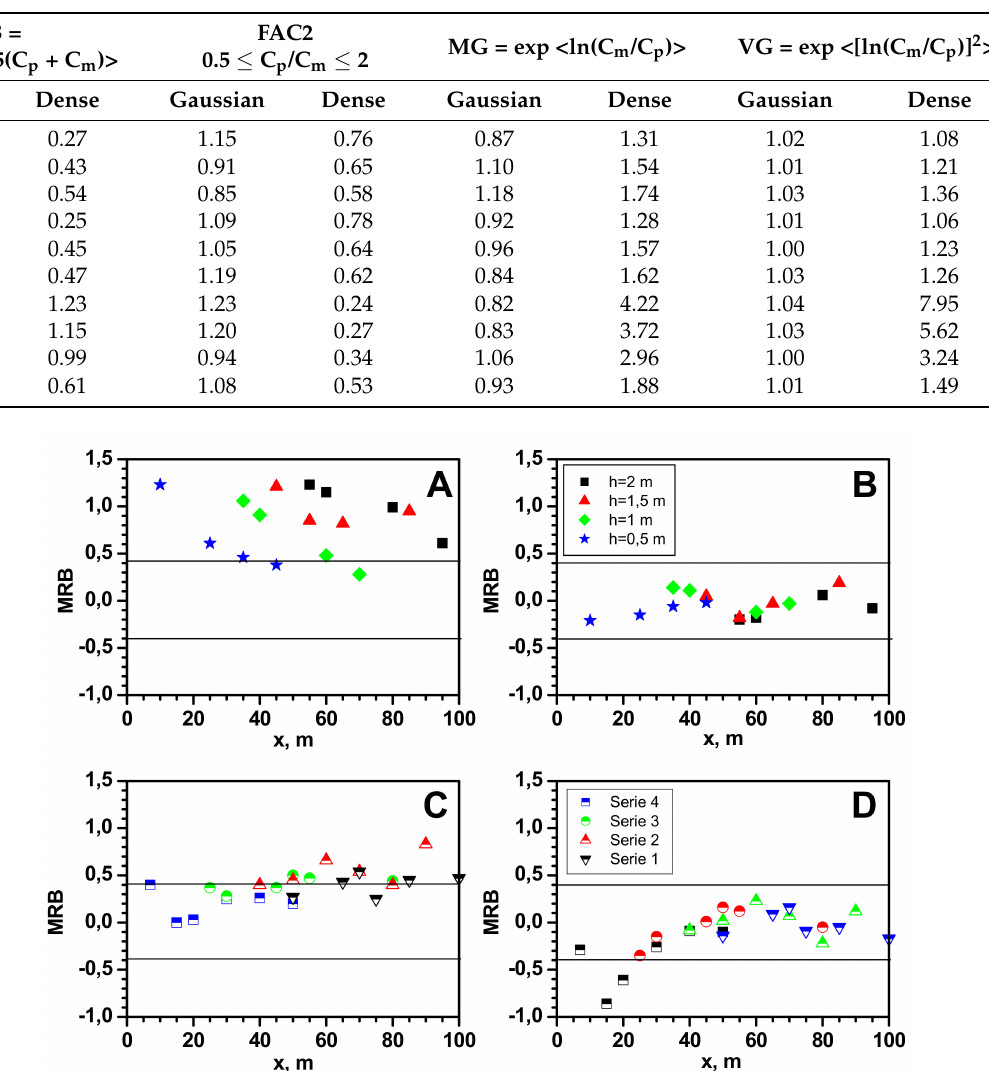
Table 6. Statistical performance measures (SPMs) of the maximum determined theoretical values (C p ) for the dense gas model and Gaussian gas model relative to the maximum recorded gas concentration (C m ) for measurement series 4. Designations: MRB—mean relative bias; FAC2—the fraction of predictions within a factor of two of the measurements; MG—geometric mean bias; VG—geometric variance; red colour—values obtained outside the range of model compliance with the experiment.